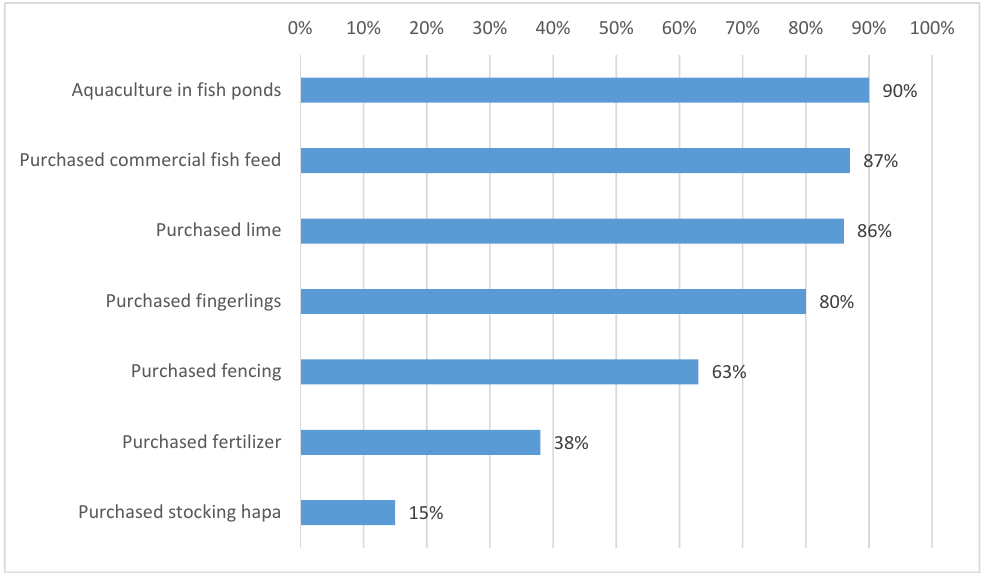
Figure 1. Adoption of fish farming technologies ( n = 324).